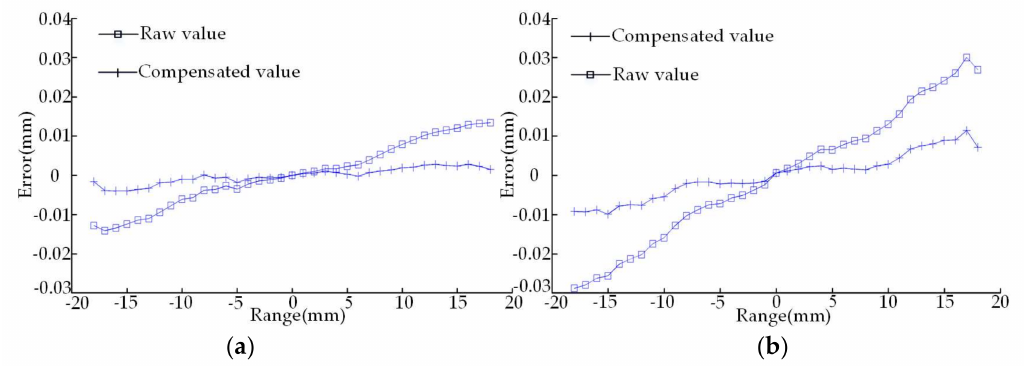
Figure 9. Inclination angle errors and compensation graph. ( a ) The experiment of 20 ◦ inclination angle error; ( b ) the experiment of 60 ◦ inclination angle